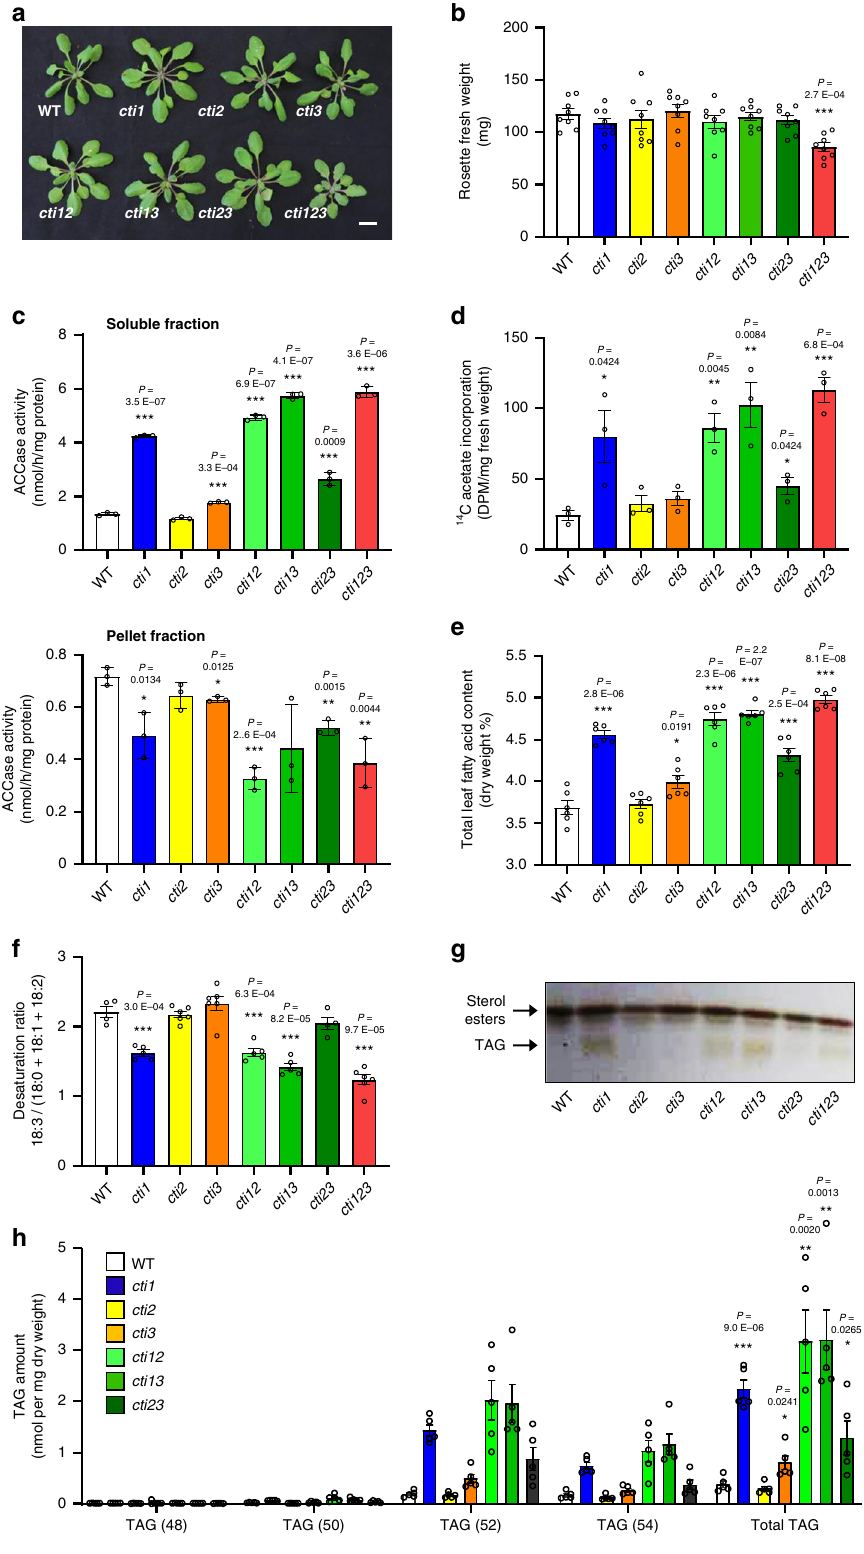
acid quanti fi cation suggested that CTIs inhibit FAS in the light. strong split-luciferase (LUC) signal could be detected (Fig. 5d). When agroin fi ltrated leaves were kept 2 d in the light then 2 d in the dark, interactions between α -CT and the CTIs appeared sig- light was suf fi cient to restore equivalent levels of α